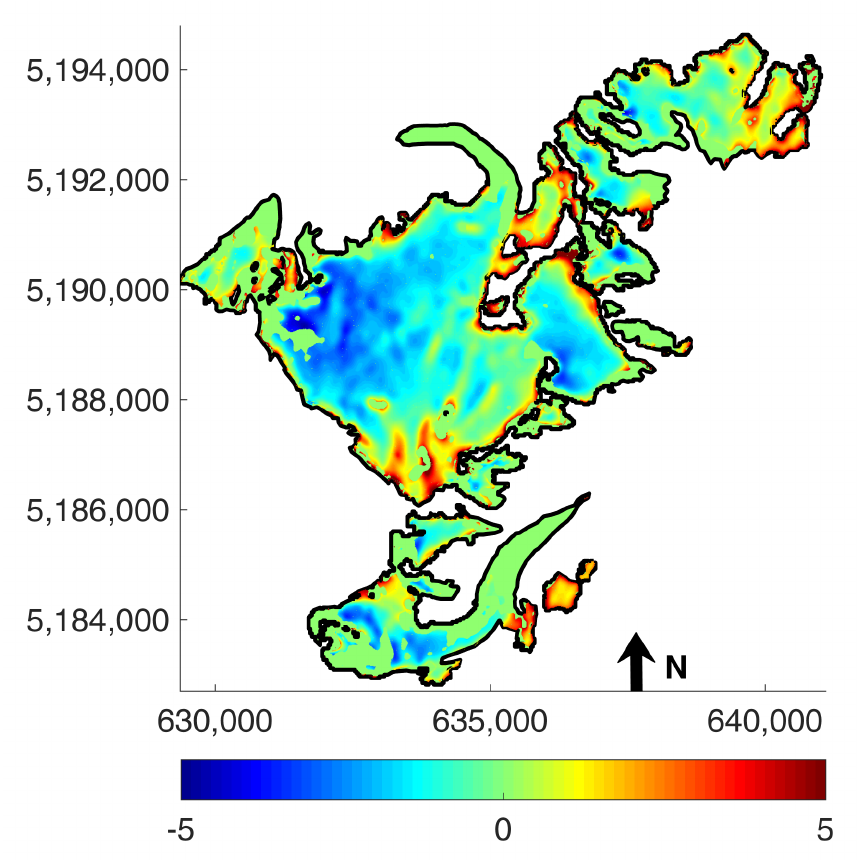
Figure 4. Applied backscatter coefficient ( γ 0 ) correction in decibel (dB), which is subtracted from each scene. Coordinates are given in UTM with datum WGS